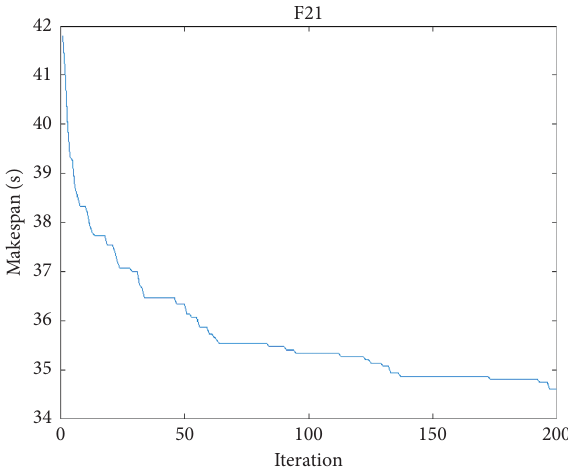
Figure 9: Convergence results on